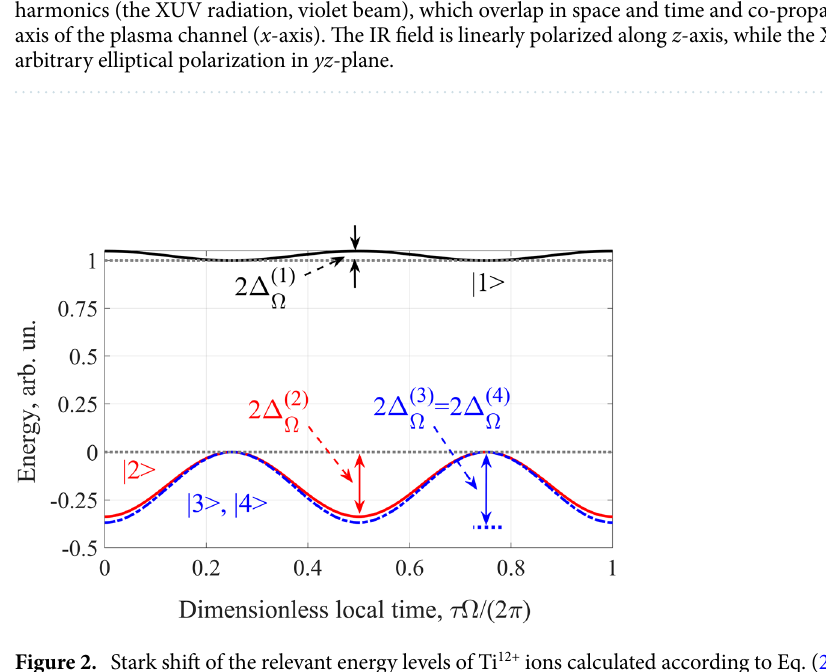
Figure 2. Stark shift of the relevant energy levels of Ti 12+ ions calculated according to Eq. (2) under the action of the IR field with intensity 8.26 × 10 16 W/cm 2 . Black and red solid curves correspond to the states |1 〉 = |3 p 1 S 0 , J = 0, M = 0 〉 and |2 〉 = |3 s 1 P 1 , J = 1, M = 0 〉 , respectively. Blue dash-dotted curve shows the degenerate energy level, which corresponds to the states |3 〉 = |3 s 1 P 1 , J = 1, M = 1 〉 and |4 〉 = |3 s 1 P 1 , J = 1, M = − 1 〉 . Grey dotted horizontal lines are the position of the upper and lower lasing energy levels in the absence of the IR